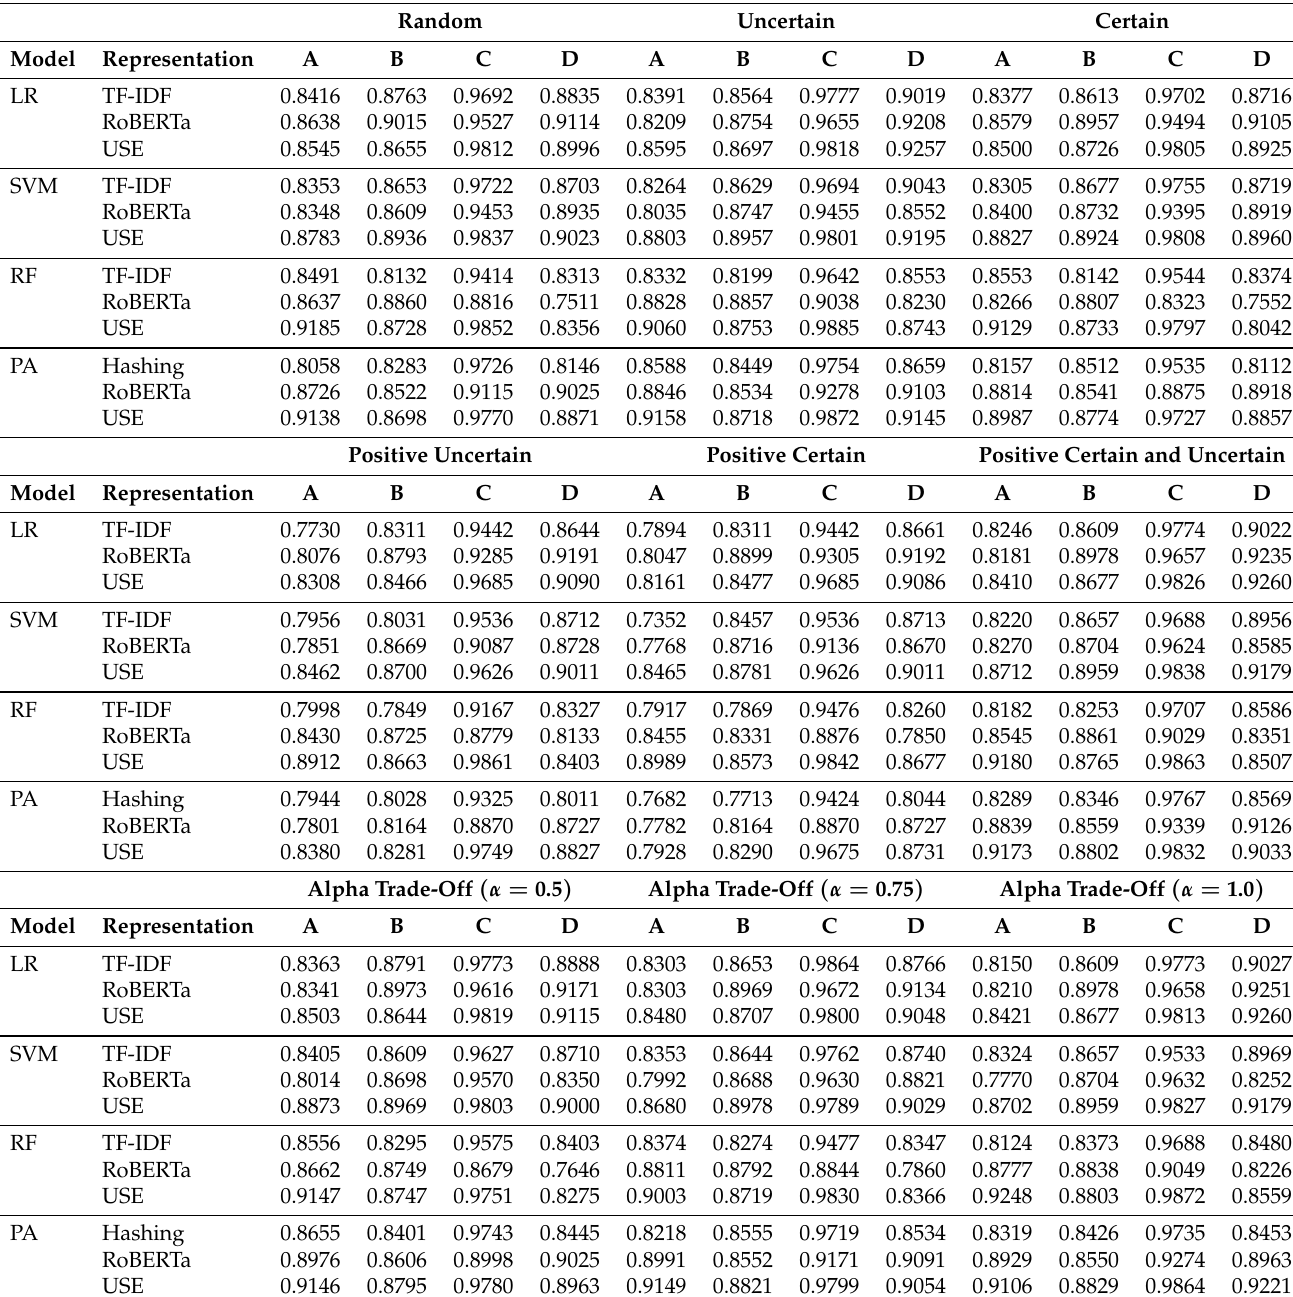
Table A2. ROC AUC scores for all